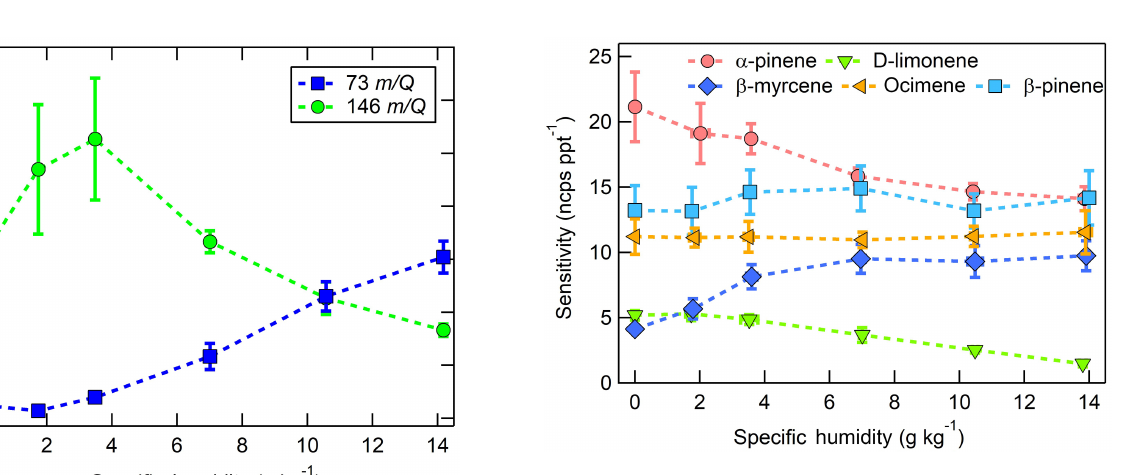
Figure 8. Humidity-dependent sensitivities to select MTs detected as M + (C 10 H + , 136 m/Q ). Error bars indicate the standard devia- 16 tion of triplicate measurements. All calibrations were conducted in zero air. Error bars represent the standard deviation of the triplicate calibrations. All calibrations were performed in zero air.